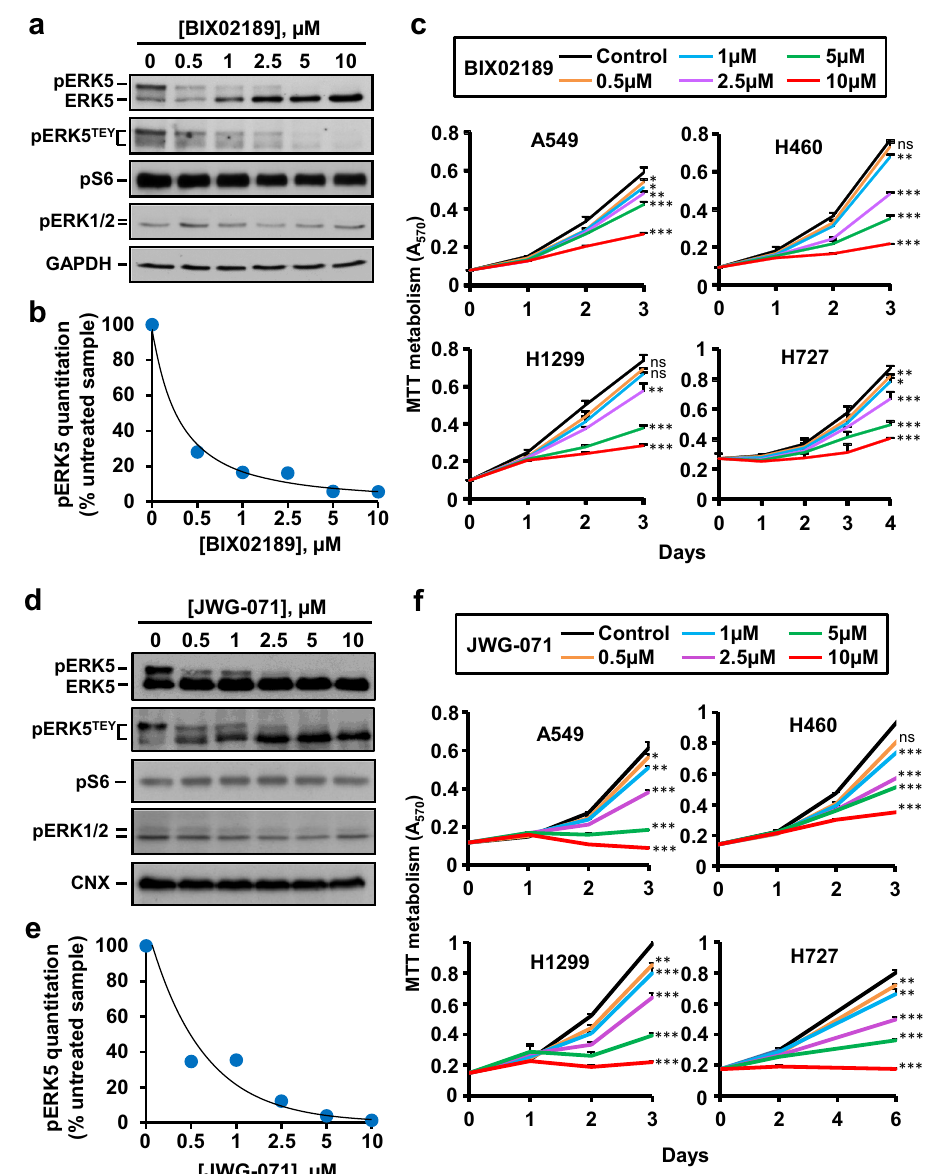
Fig. 4 MEK5 and ERK5 inhibitors reduced cell proliferation of lung cancer cells. a H460 cells were treated with increasing doses of BIX02189 for 72 h and the effect of the drug on ERK5 activation was evaluated by immunoprecipitation of 1 mg of whole-cell lysates and western blotting with the anti-ERK5 or anti-pERK5 TEY antibodies. pS6 and pERK1/2 were used as controls to assure that BIX02189 did not affect the PI3K and ERK1/2 routes. GAPDH was used as loading control. b Quantitation of pERK5 band in H460 cells from ( a ) using the ImageJ software. Data represent the percentage of the upper pERK5 band after BIX02189 treatment with respect to such band in control H460 untreated cells. c NSCLC cells were plated in 24-well dishes and treated with increasing doses of BIX02189. Cell proliferation was measured at the indicated times by MTT. Results are expressed as mean ± SD of an experiment that was repeated three times. * p ≤ 0.05; ** p ≤ 0.01; *** p ≤ 0.001. The exact p -values are shown in Supplementary Table 1a. d H460 cells were treated with increasing doses of JWG-071 for 7 h. Inhibition of ERK5 activation was evaluated by immunoprecipitation of 1.3 mg of whole-cell lysates with the anti-ERK5 antibody and probed with the C terminal anti-ERK5 or anti-pERK5 TEY antibodies. pS6 and pERK1/2 were used as controls to assure that JWG-071 did not affect the PI3K and ERK1/2 routes. GAPDH was used as loading control. e Quantitation of pERK5 bands was performed as in ( b ). f NSCLC cells were plated in 24-well dishes and treated with increasing doses of JWG-071. Cell proliferation was measured at the indicated times by MTT. Results are expressed as mean ± SD of an experiment that was repeated three times. * p ≤ 0.05; ** p ≤ 0.01; *** p ≤ 0.001. The exact p -values are shown in Supplementary Table decreased, in a dose and time-dependent fashion, the prolifera- tion of the four lung cancer cell lines (Fig. 4f and Supplementary Table 1b). Similar biochemical (Supplementary Fig. 4e and f) and biological (Supplementary Fig. 4g and Supplementary Table 1c) results were obtained by using XMD8-92, an alternative ERK5 inhibitor 19 . the G1 phase of the cell cycle (Fig. 5a and Supplementary Table